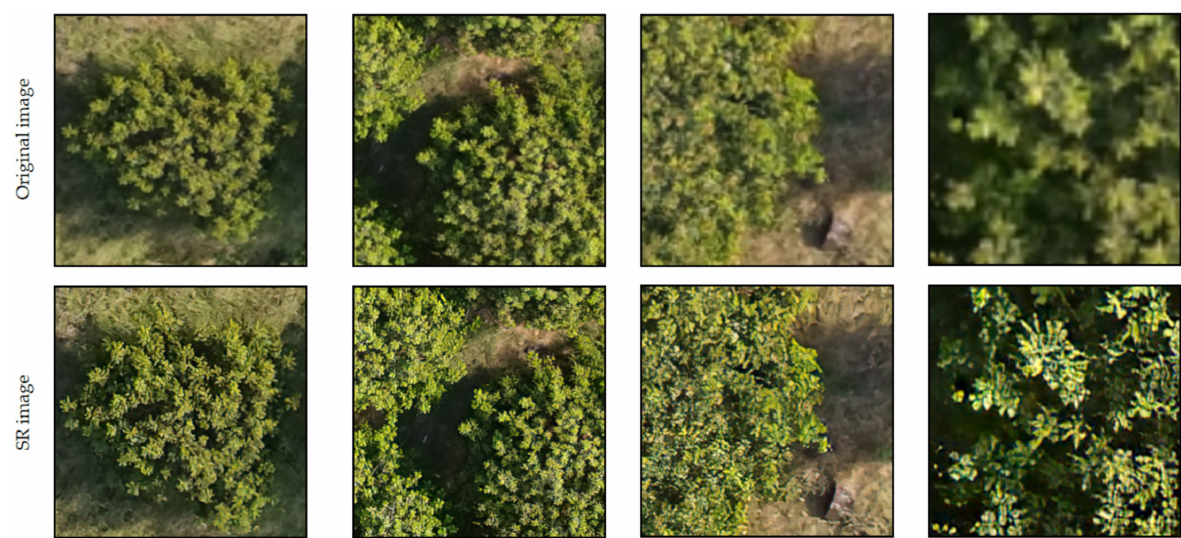
Figure 3. Super-resolution (SR) reconstruction